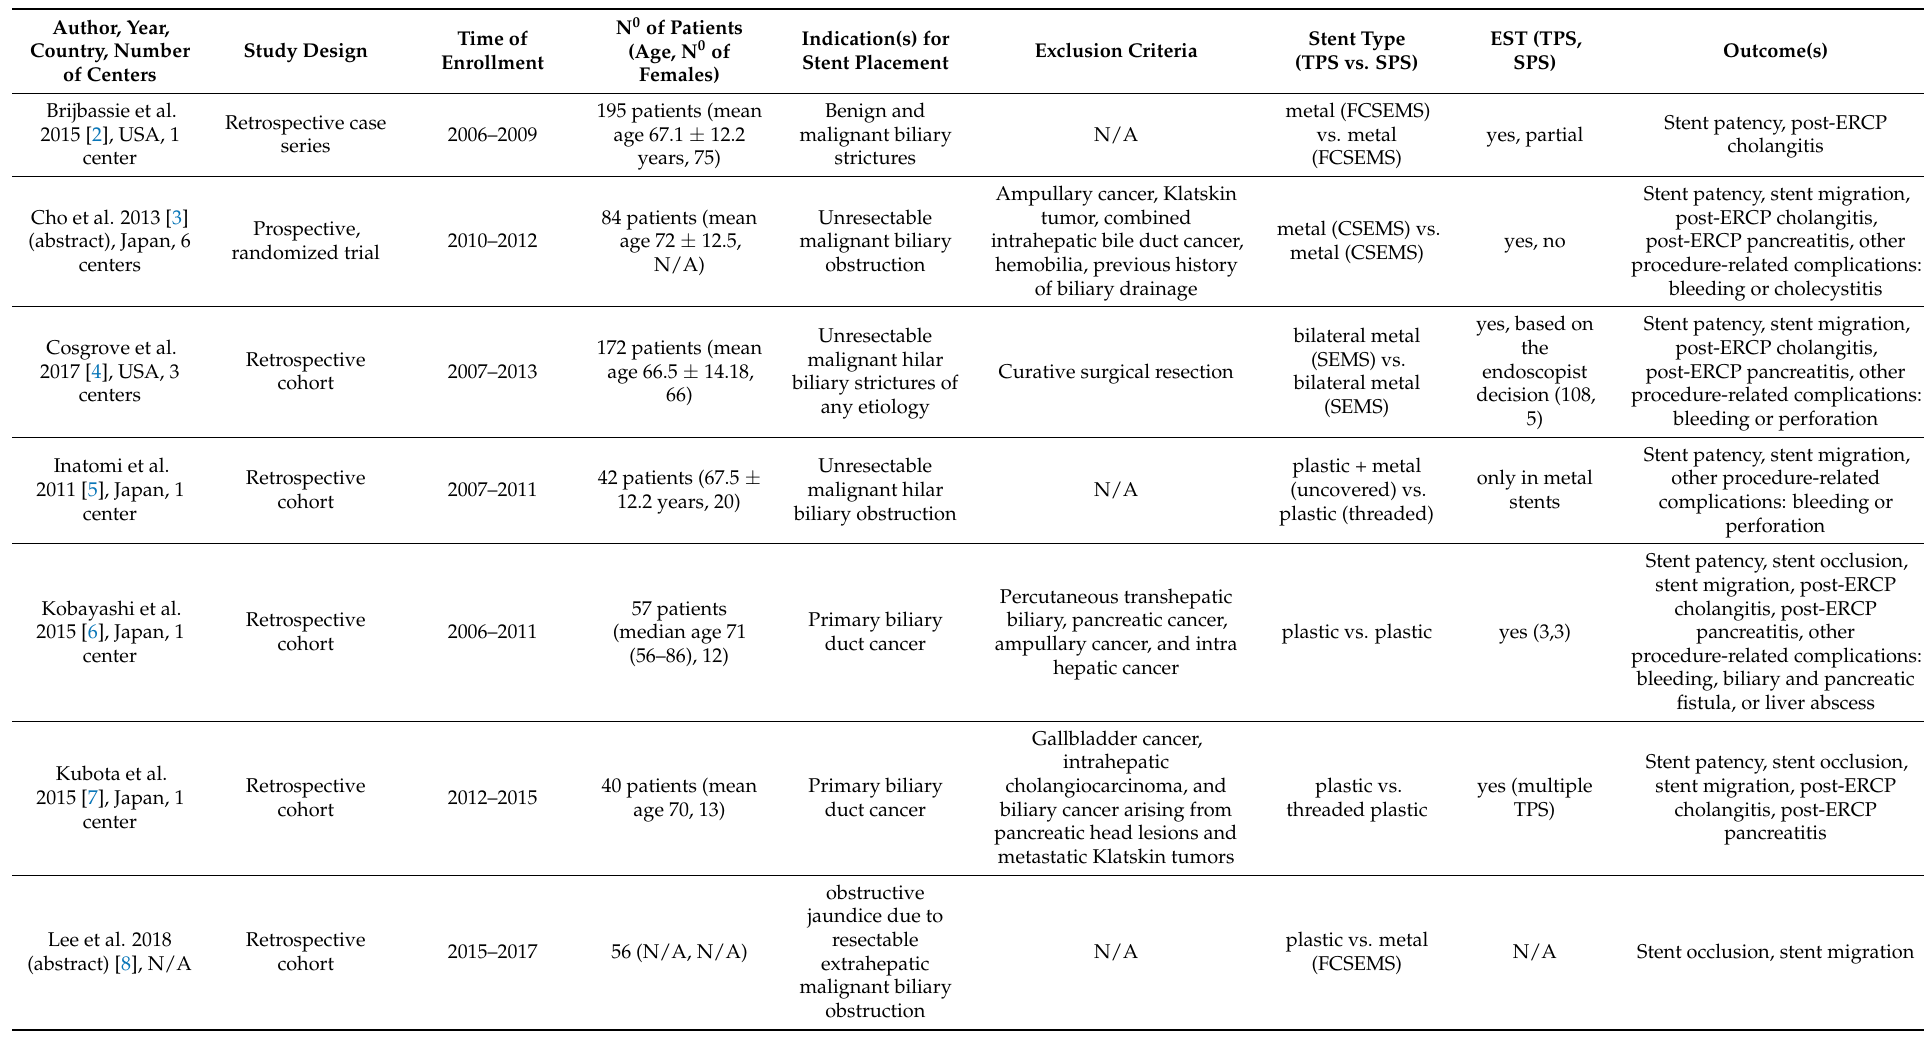
Table 1. Characteristics of included